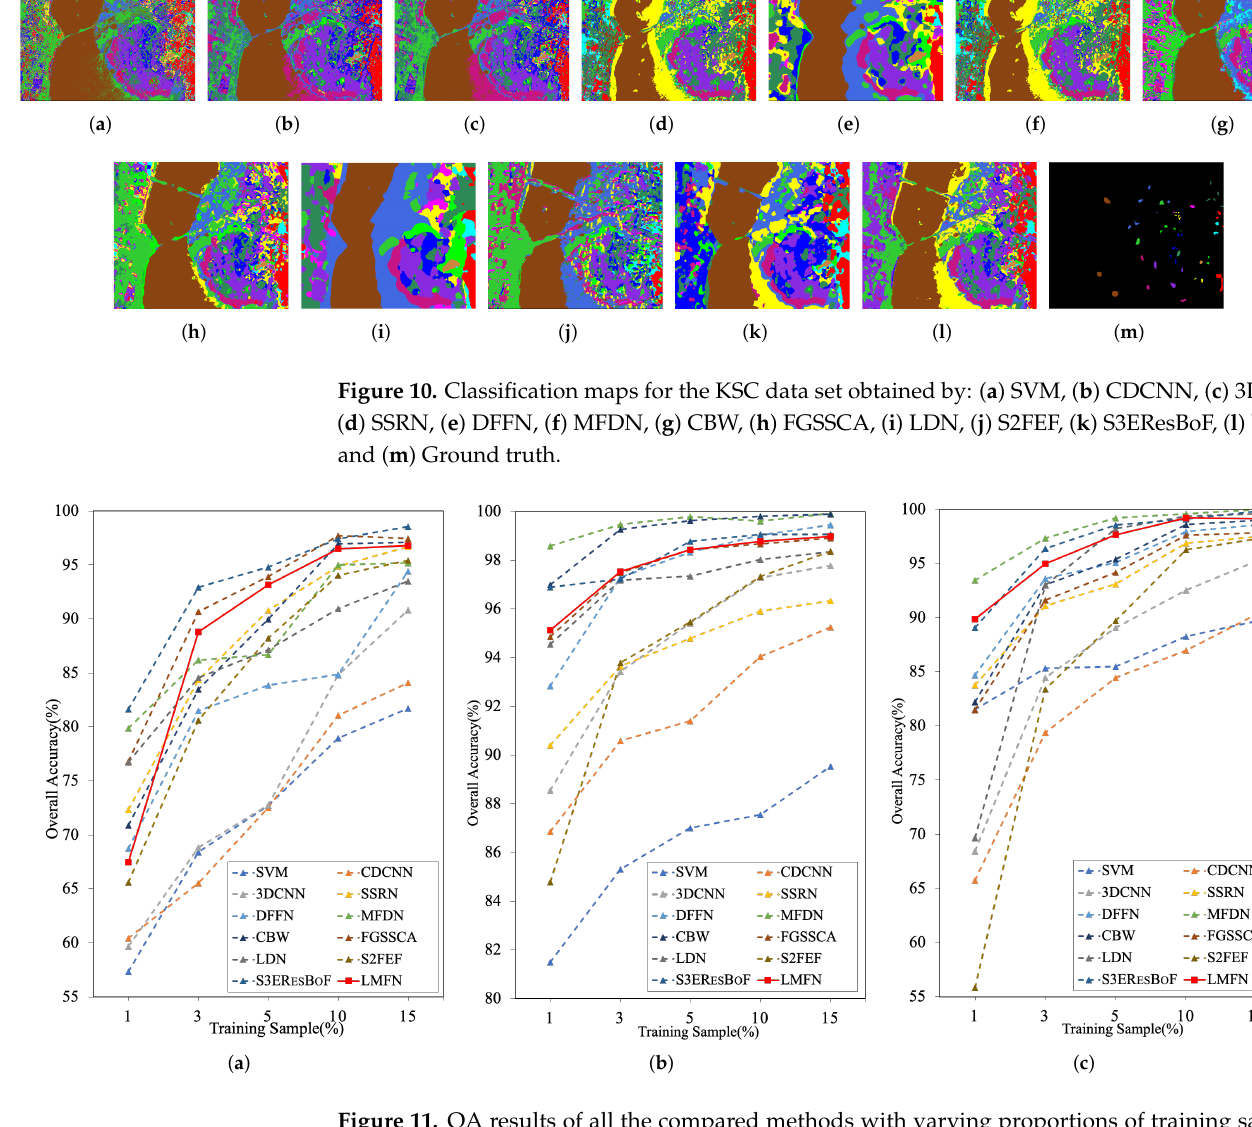
Figure 11. OA results of all the compared methods with varying proportions of training samples (from 1 to 15%) on the ( a ) IN, ( b ) UP, and ( c ) KSC data